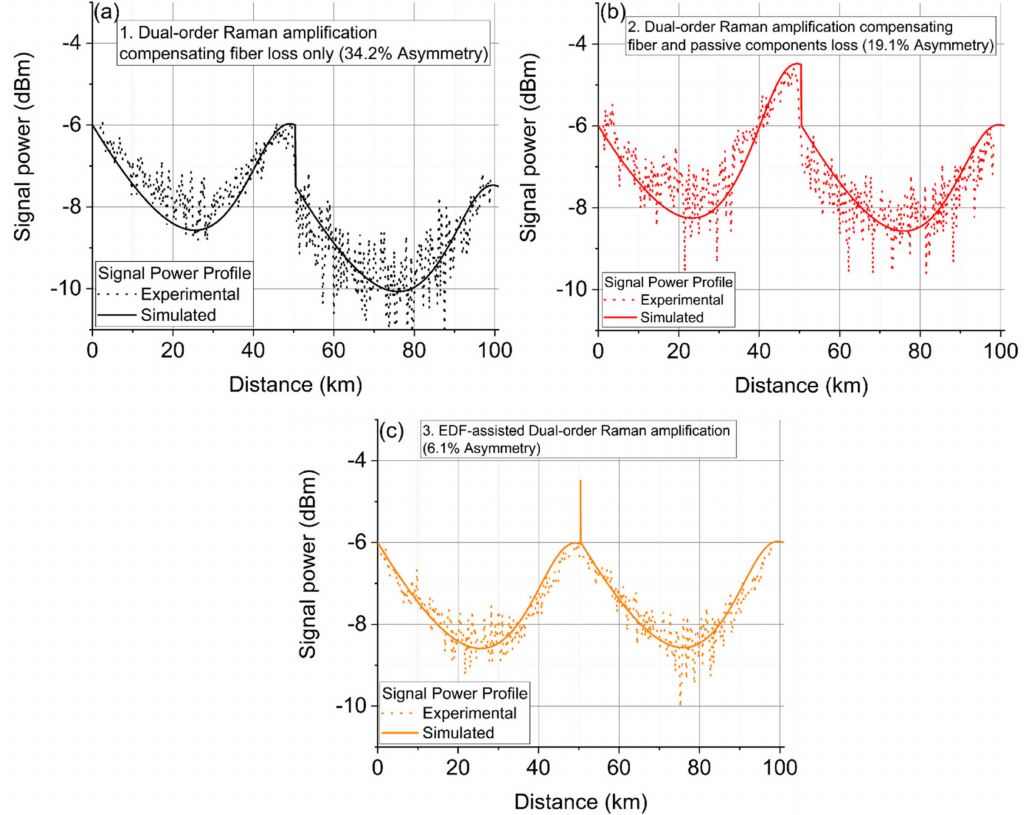
Figure 13. Experimentally measured and simulated signal power profiles along the fiber with three Raman amplification schemes; ( a ) DRA compensating only the fiber loss. ( b ) DRA compensating the fiber and the passive components loss between the two spans. ( c ) EDF-assisted DRA compensating fiber and the passive components loss between the two